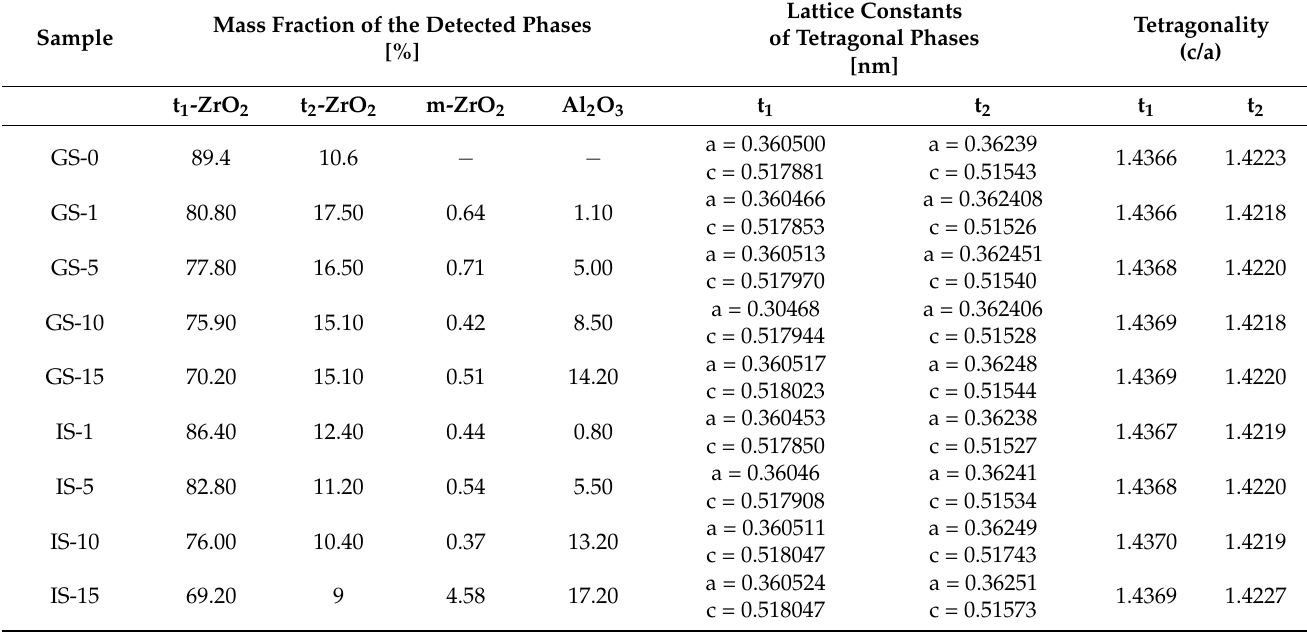
Table 3. Mass fractions of the phases identified for samples sintered for 2 h in air at 1773 K as well as the lattice constants of the t 1 and t 2 tetragonal phases and the corresponding degree of